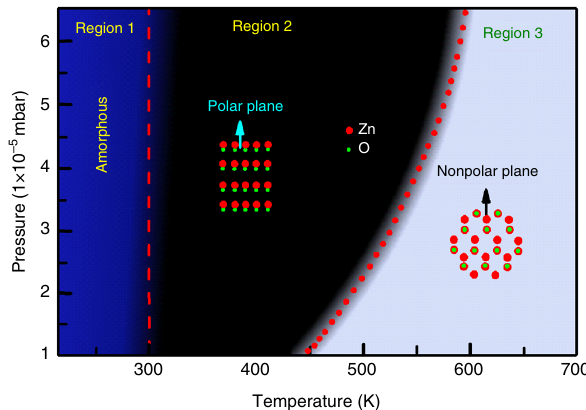
Fig. 1 Diagram of the ZnO growth orientations. The transformation of the growth orientation is tailored by the growth temperature and O 2 partial pressure. It is similar to a conventional phase transition from water to water-vapor 22,23 or a pressure-temperature relationship diagram of the reaction CaMg(CO 3 ) 2 (dolomite) + 2SiO 2 ( coesite) = CaMgSi 2 O 6 (diopside) + 2CO 2 (vapor)